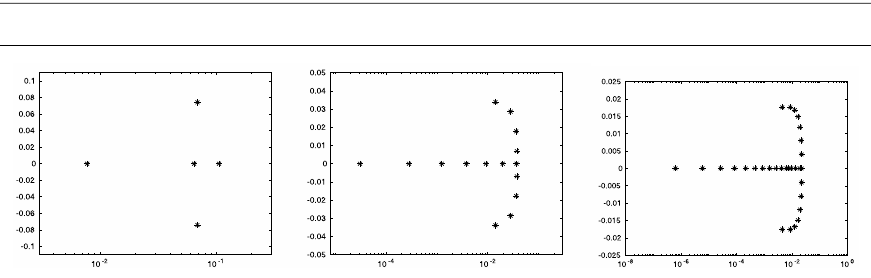
Figure 11 Eigenvalues of U n in the case of an algebraic/square-logarithmic weight function, with exponent α = 1/2, for n = 5,15,30 (from left to